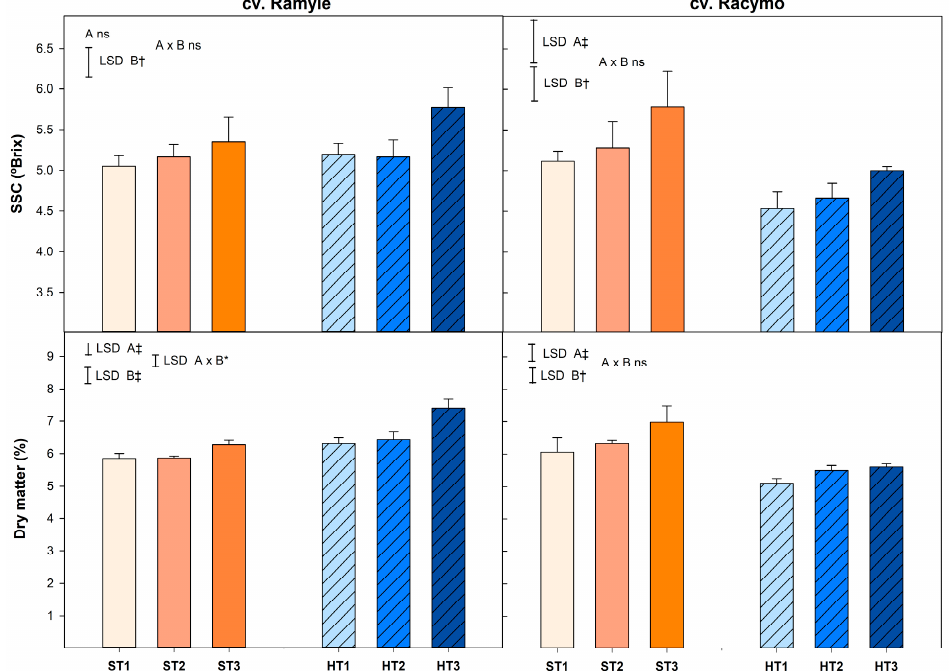
Figure 1. Soluble solid content (SSC) and dry matter content of two tomatoes (cvs. Ramyle and cv. Racymo) under different irrigation treatments (T1: desalinated seawater with low electrical conductivity (EC); T2: well/desalinated water, intermediate EC; and T3: well water with high EC) and cultivation systems (traditional soil system, S; hydroponic, H) ( n = 3 ± SD). The uppercase letters A and B denote cultivation system and irrigation treatment, respectively. ns, †, and ‡ signi fi cance for p ≤ not significant, 0.01, and 0.001, respectively.